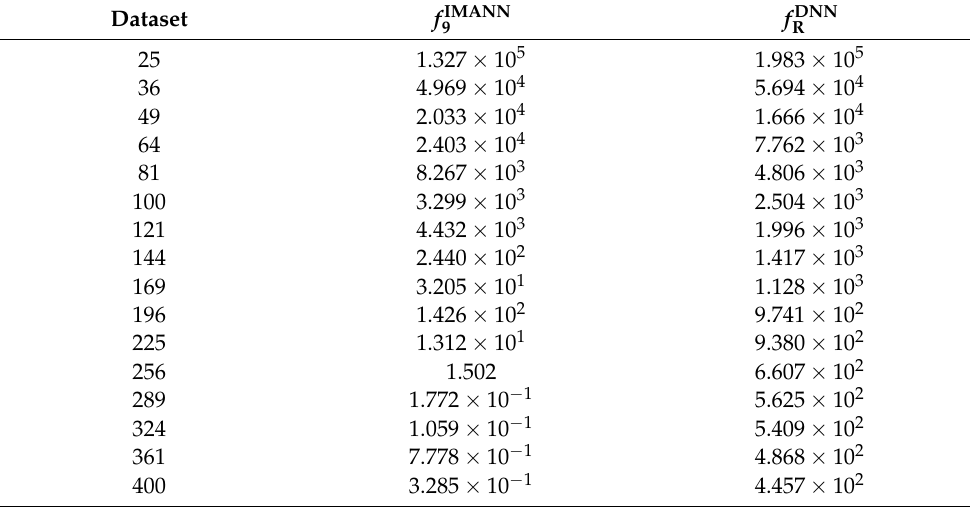
Table 4. Mean integral squared error value R m .